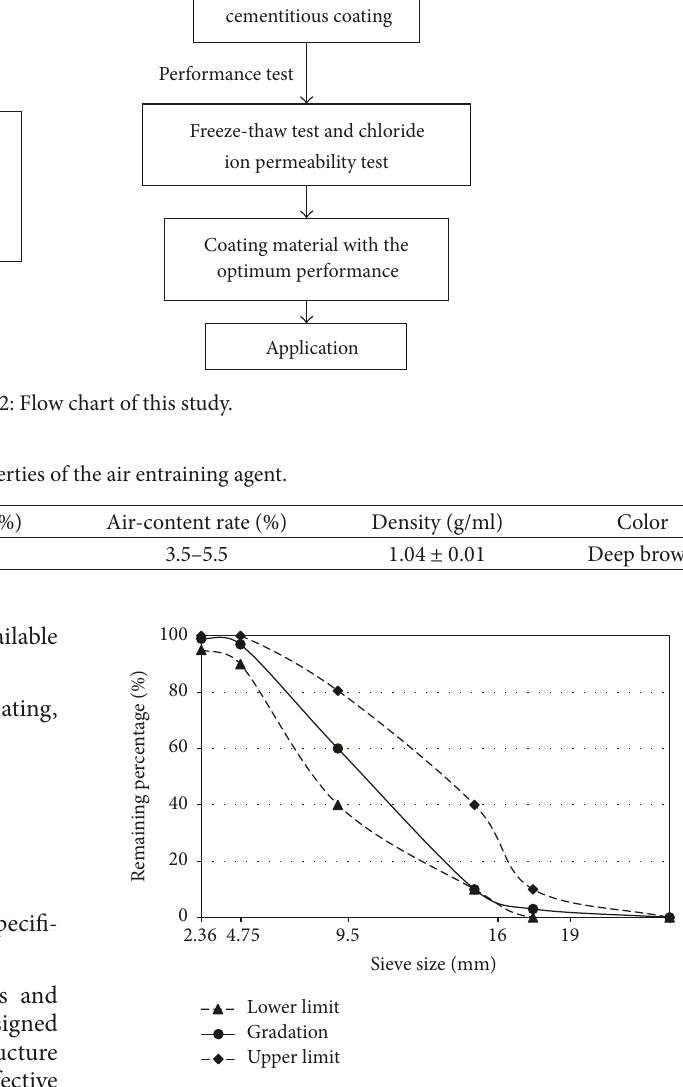
Figure 3: Gradation of the mixture of gravels and